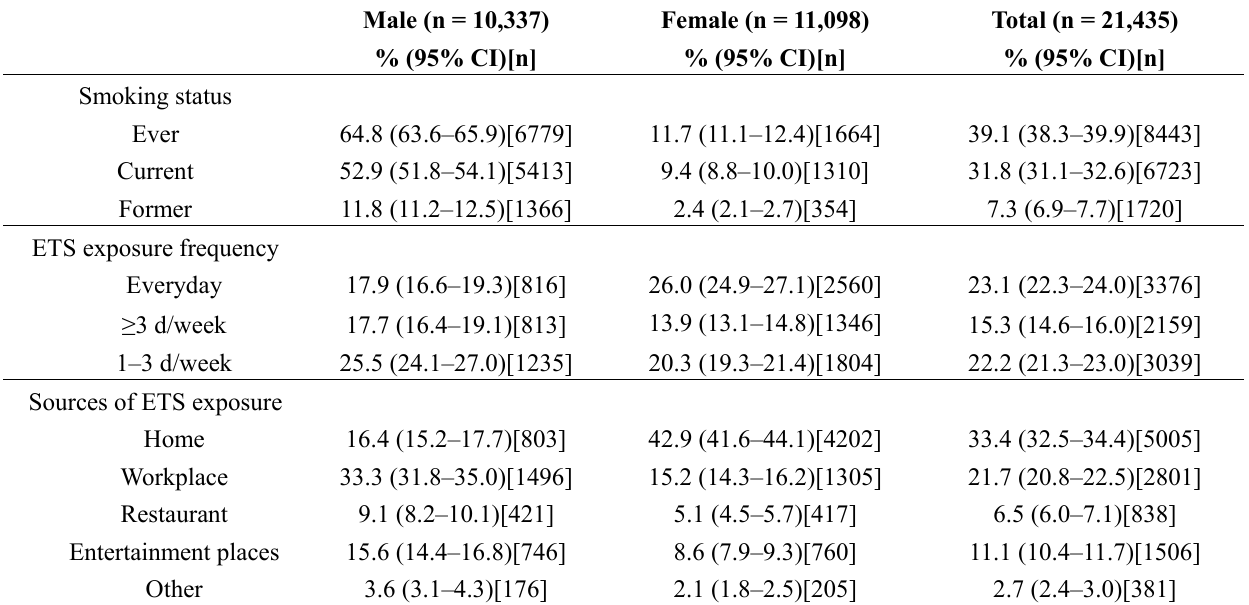
Table 1. Prevalence of smoking and environmental tobacco smoke (ETS) exposure among adults from Jilin Province, China in